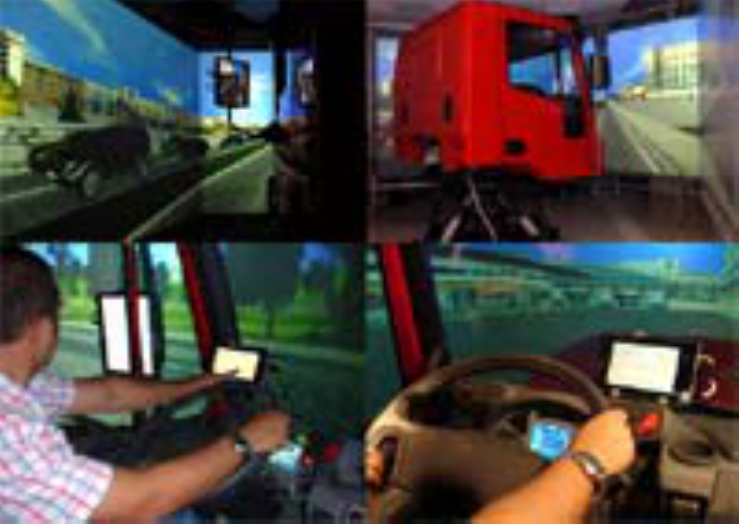
Figure 3. Immersive environment for the